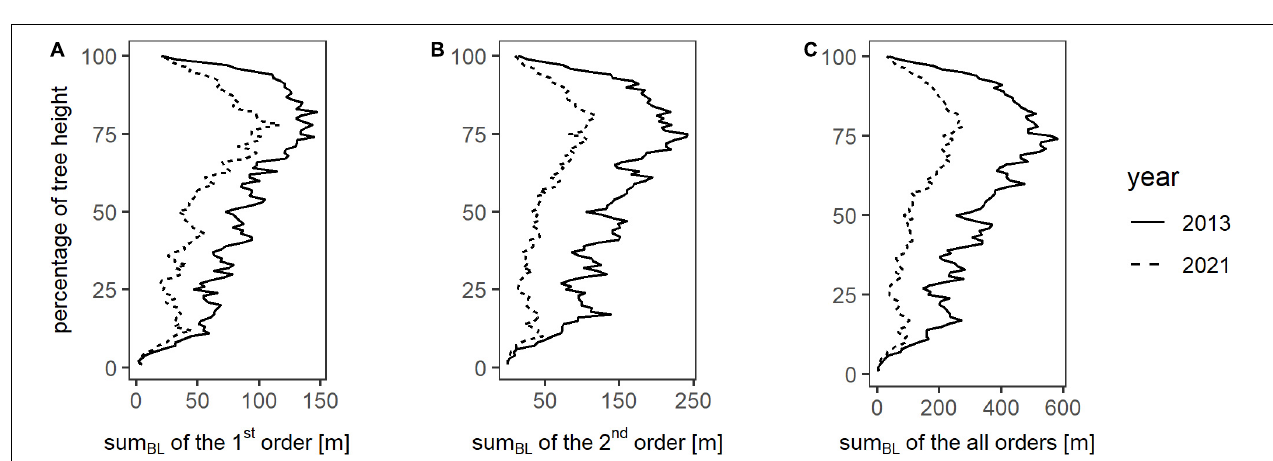
FIGURE 4 | Total branch lengths (sum BL ) over one percent steps of the respective tree height on plot level for winter 2013 (dotted line) and winter 2021 (continuous line) for the branch orders one (A) , two (B) , and all branch orders combined (C)